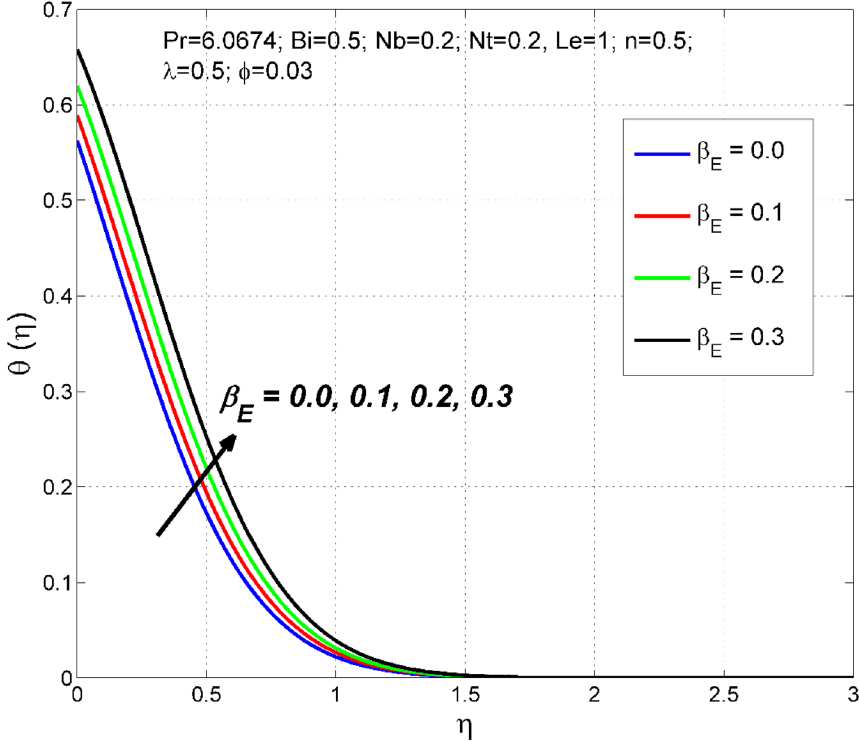
Figure 9. The temperature distribution θ (η) behavior for the variation of the exponential heat source β E .